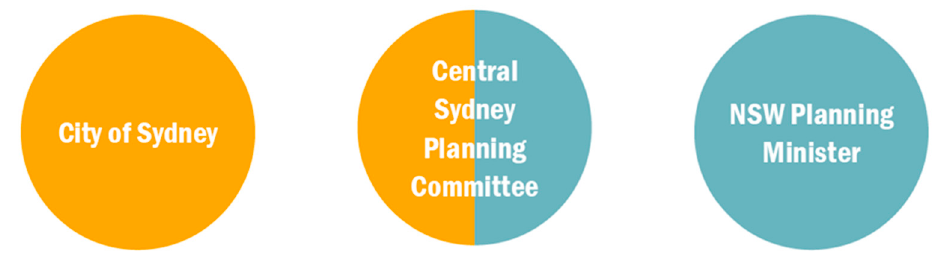
Figure 2. Consent authorities in CoS and their power composition.